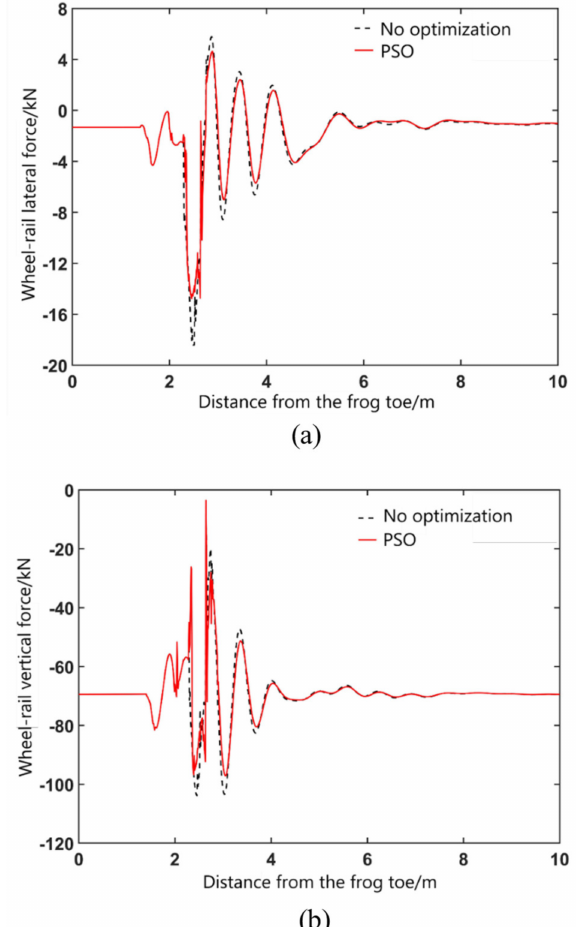
Figure 17. On the frog side: ( a ) Wheel/rail lateral force; ( b ) Wheel/rail vertical